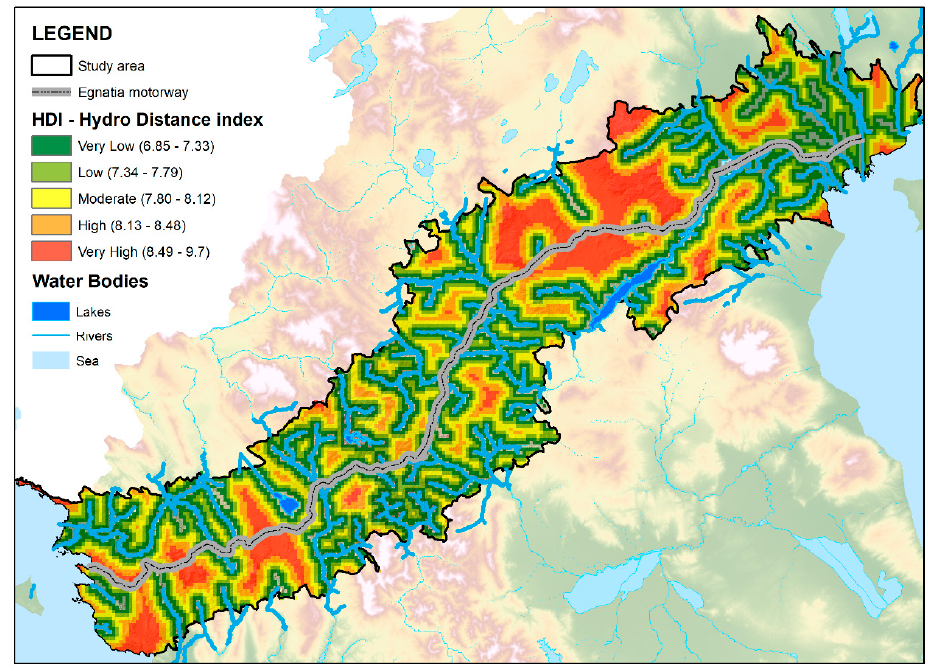
Figure 4. Spatial distribution of the HDI (Hydro Distance Index).